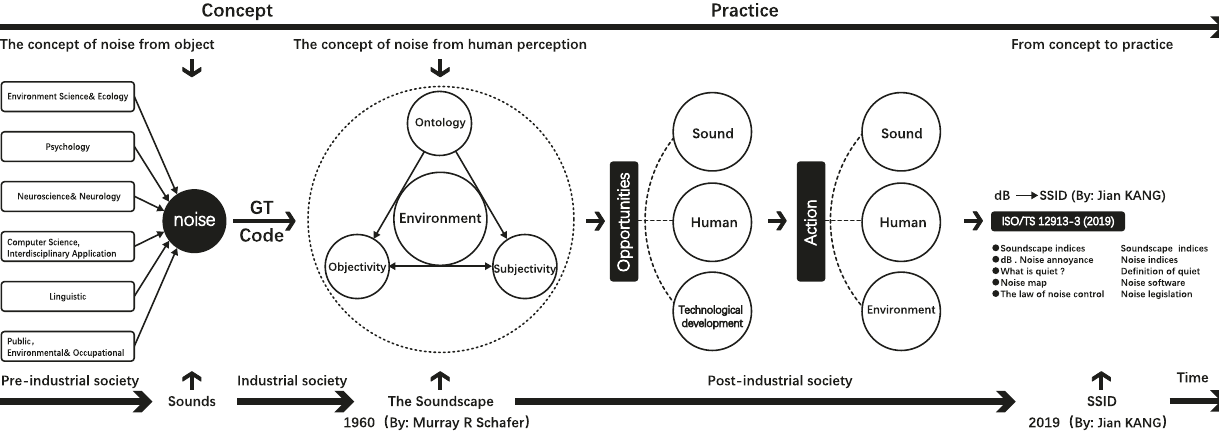
Fig. 7 From “ noise control ” to “ soundscape ” to